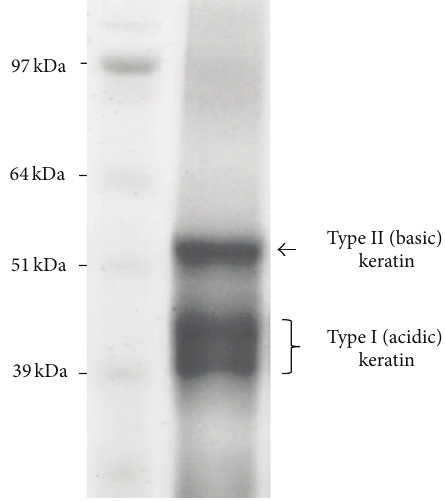
Figure 1: SDS-PAGE analysis of proteins extracted from hair. Lane 1 : protein ladder; Lane 2 : representative coomassie blue- stained sample of hair-extracted proteins, where the presence of two dominant fractions of keratins is